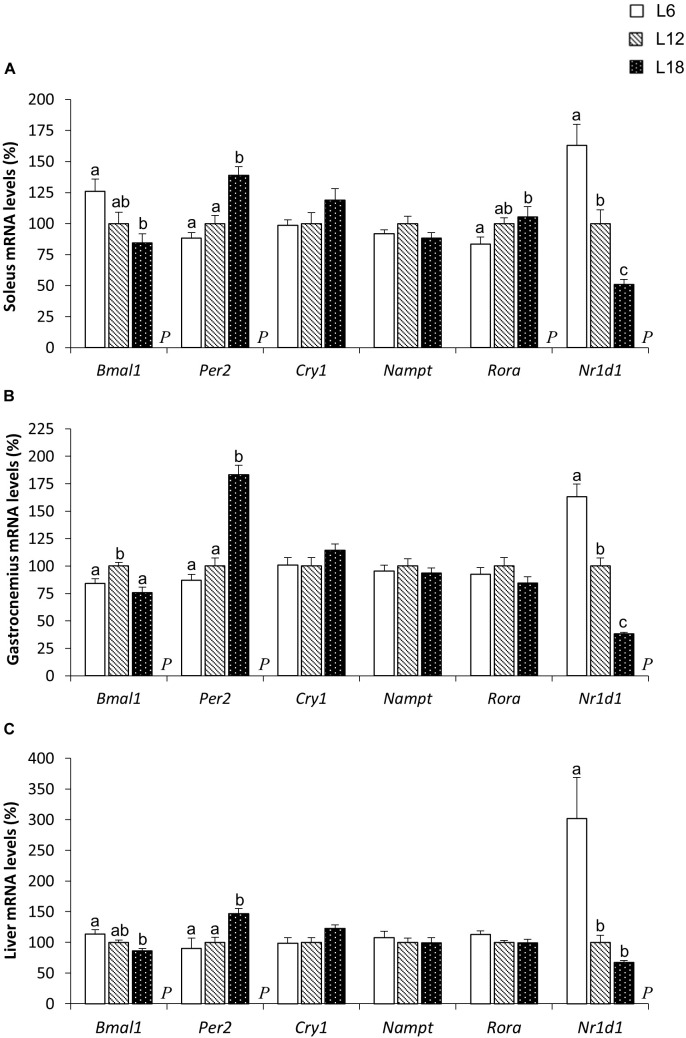
The mRNA expression of circadian core-clock genes in the soleus (A) and gastrocnemius (B) muscles and the liver (C) in male F344 rats exposed to three different photoperiods for 11 weeks and fed a cafeteria diet for the last 7 weeks. Data are expressed as the mean ± SEM (n = 8). P, photoperiod effect. abcMean values with unlike letters were significantly different among groups (one-way ANOVA and Duncan’s post hoc test). Bmal1, brain and muscle Arnt-like protein-1; Cry1, cryptochrome circadian clock 1; Nampt, nicotinamide phosphoribosyltransferase; Nr1d1, nuclear receptor subfamily 1, group D, member 1; Per2, period circadian clock 2; Rorα, RAR-related orphan receptor alpha.